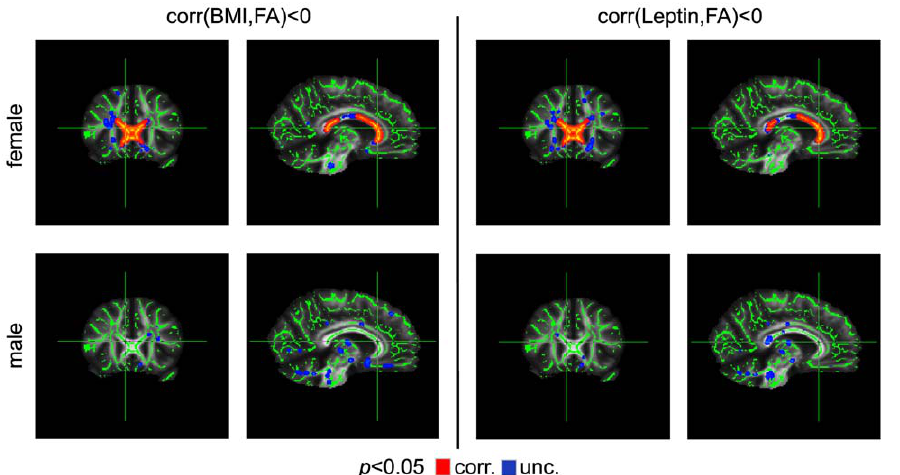
Figure 1. Sex-specific correlations between FA and body weight using BMI (left columns) and serum leptin level (right columns). For women (top row), we found a significant negative correlation in the entire corpus callosum ( p , 0.05, corrected). In contrast, for men (bottom row), we found no correlation even without correcting for multiple comparisons.